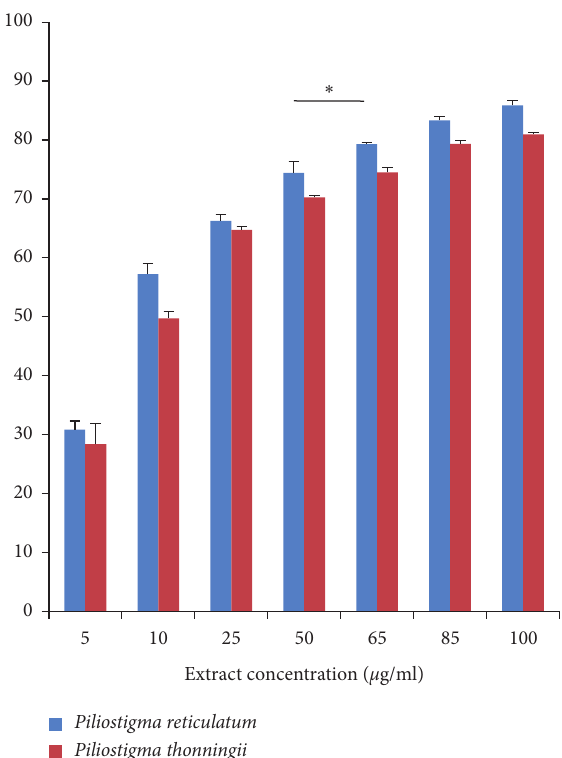
Figure 2: DPPH scavenging ability of P. reticulatum and P. thonningii methanolic leaves extracts. The kinetics of the two extracts is significantly different ( p < 0 .